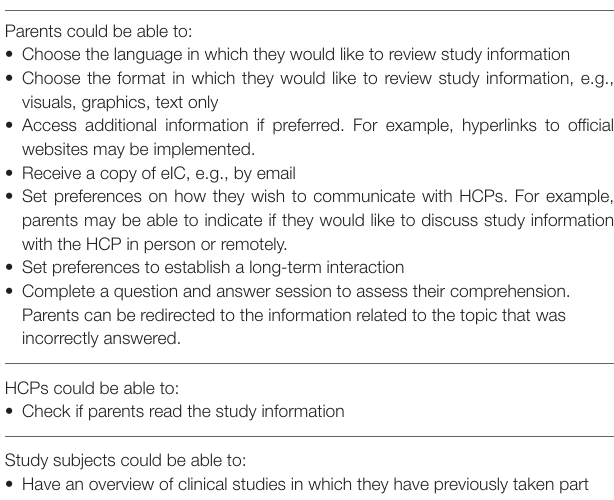
TABLE 2 | Overview of opportunities for a personalized eIC interface according to